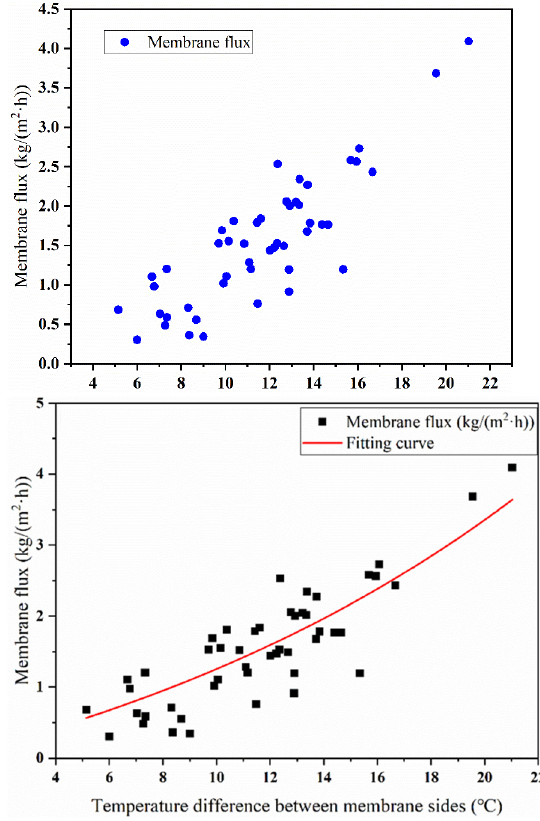
Figure 10. Scatter diagram and fitting curve of MF with temperature difference of membrane.